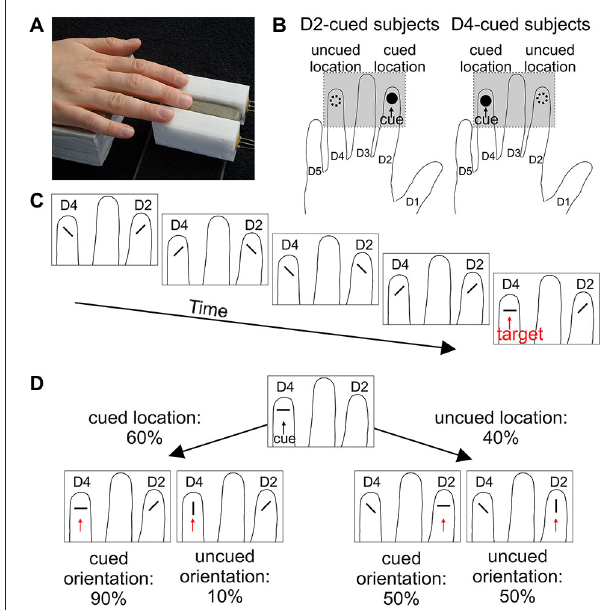
FIGURE 2 | Stimulus placement and paradigm. (A) Placement of the right-hand index (D2) and ring (D4) finger onto the two radial stimulators shown in Figure 1 . (B) Cue location. For both cue-location groups, the respective cued location (black circle), and the uncued location (dashed circle) are illustrated on a schematic hand. The gray rectangle defines the part shown in C and D . (C) Example of the sequence of events in a trial. Within each trial, subjects had to attend to the presentation of a random series of two diagonal orientations and react upon presentation of a parallel or orthogonal orientation (target) at any of the two locations. (D) At the beginning of each block, a cue with either orthogonal (shown here for a D4-cued subject) or parallel orientation was presented. Targets were more likely (60%) to occur at that cued location (panel in lower left) compared to the uncued location (40%, panel lower right). The orientation of the cue was only informative at the cued location, such that 90% of the targets presented there matched the orientation of the cue (orientation-matched targets); at the uncued location, both target orientations appeared with the same probability. Hence, in most of the trials (54%), targets matched the location and orientation of the cue. In the remaining trials, targets matched the location, but not the orientation of the cue (6% of all trials), or were presented at the uncued location with either matched or unmatched orientation (20%